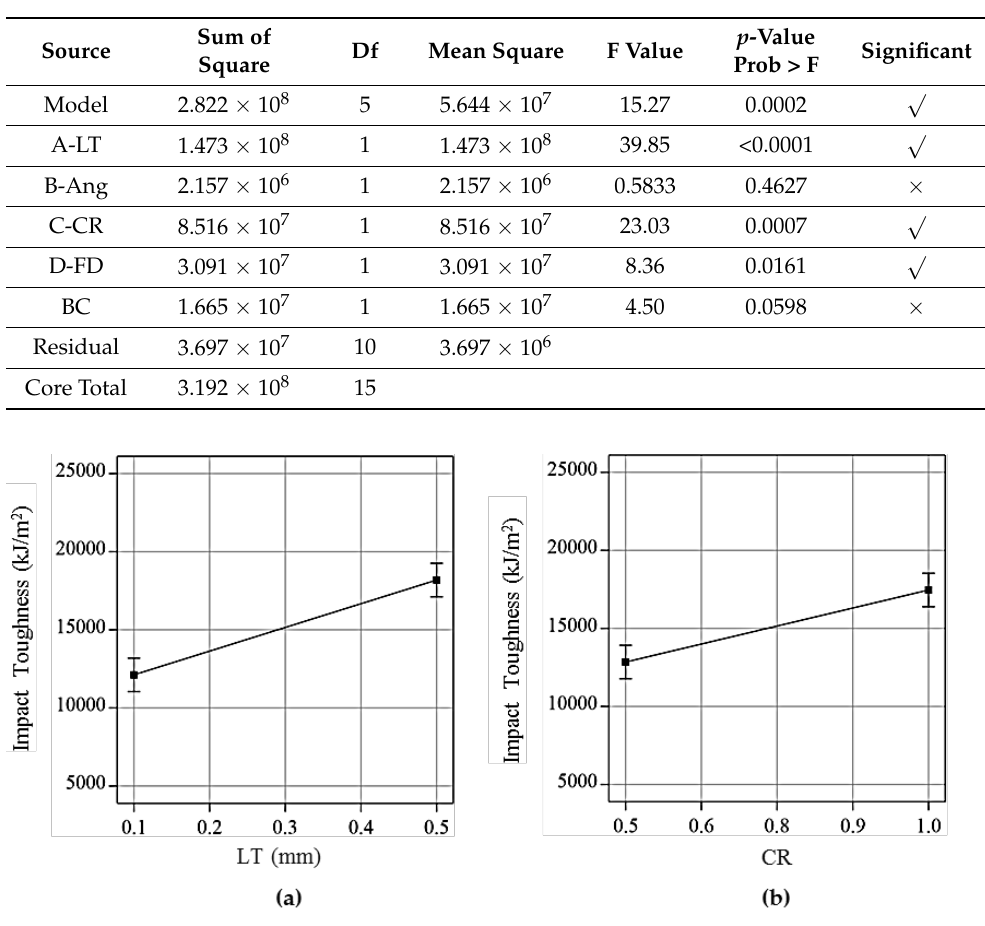
Table 6. Comparison between the present and past studies.